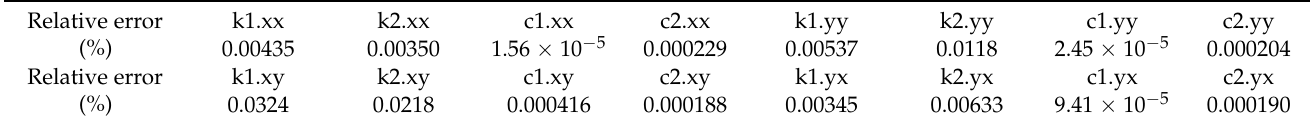
Table 18. The biggest identification error using the computational example